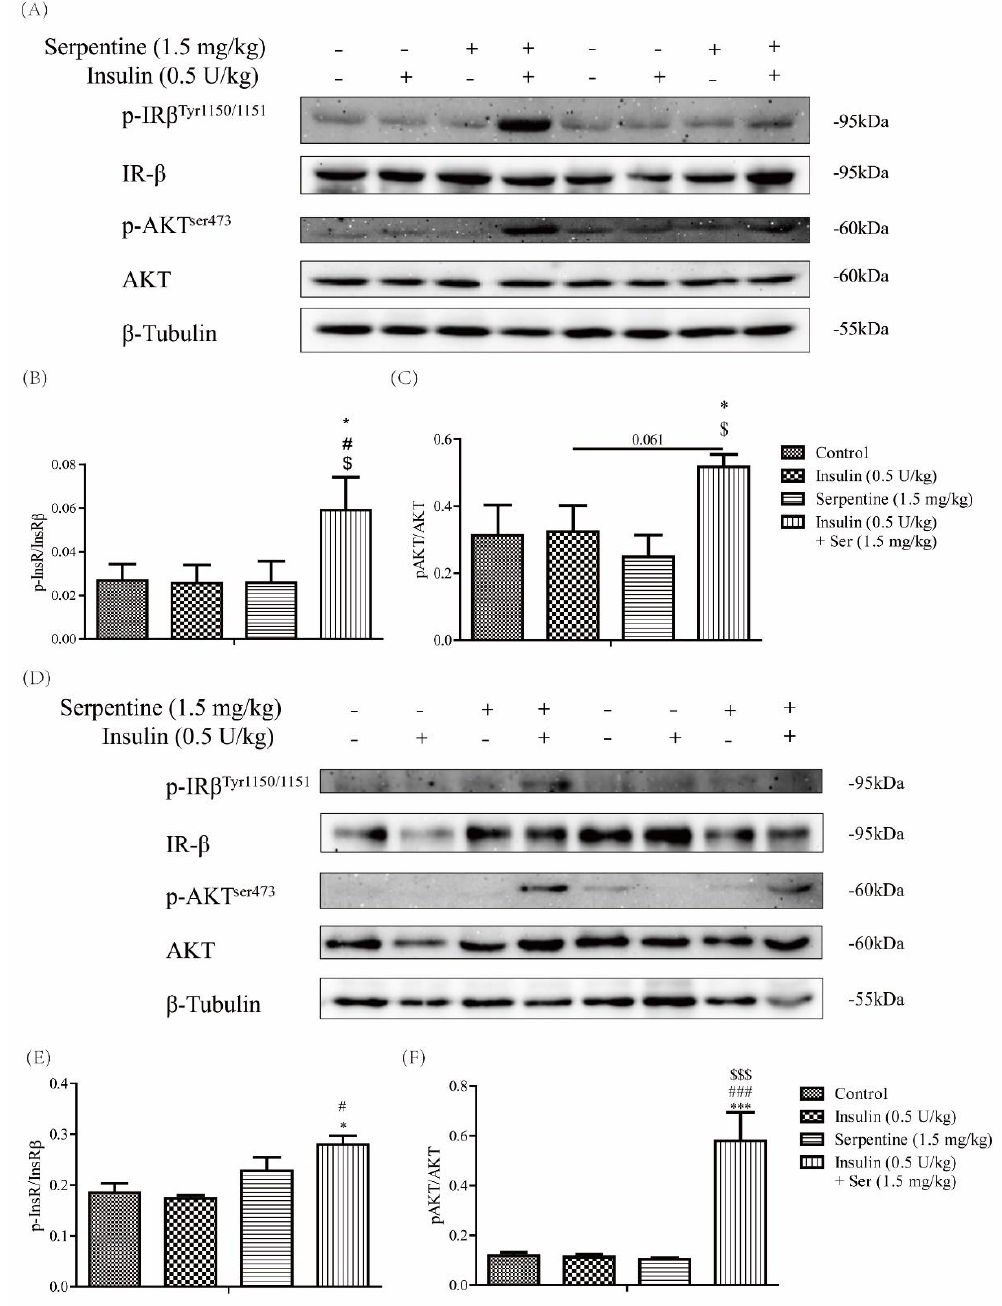
Figure 4. Effects of serpentine and insulin treatment on insulin signaling pathways in target organs. ( A – C ) Expression- and gray-level analysis of key proteins of the insulin pathway in muscle tissue. ( D – F ) Expression- and gray-level analysis of key proteins of the insulin pathway in